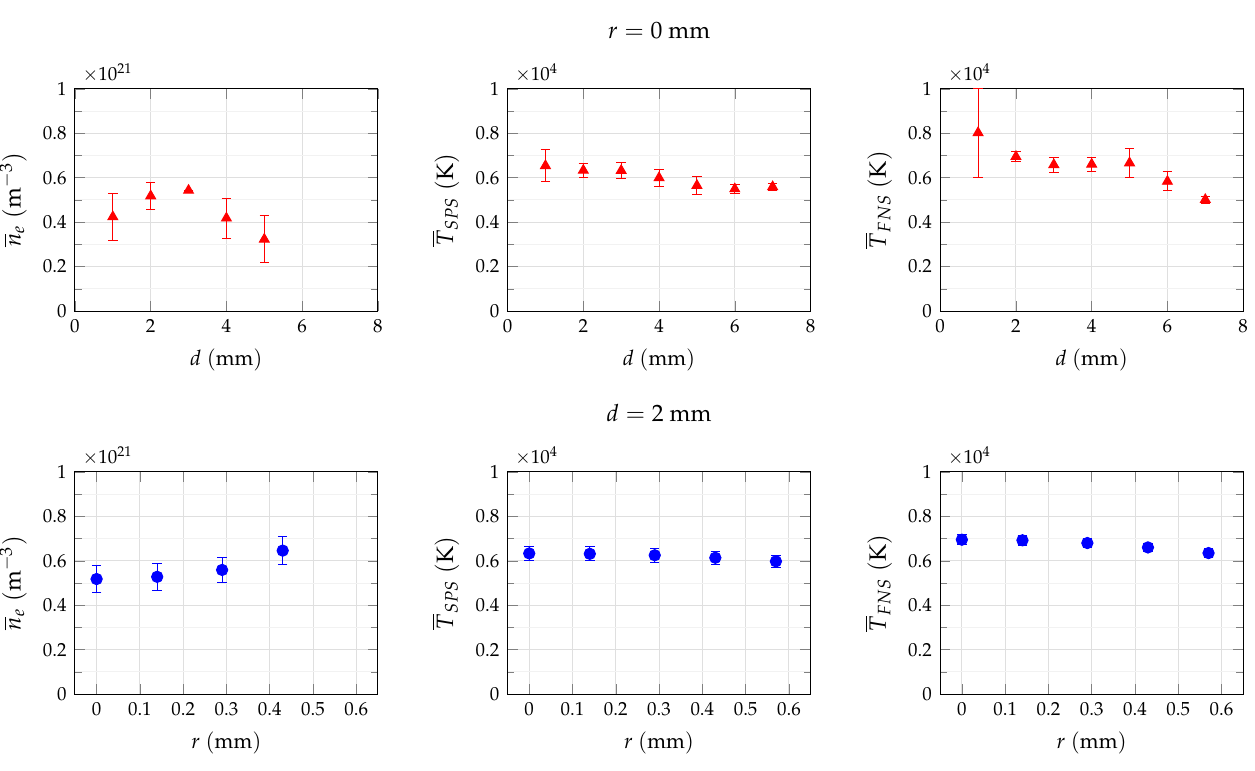
Figure 6. Average electron density ( n e ) and heavy particle temperatures ( T SPS , T FNS ) estimated on nozzle axis (first row of plots denoted with r = 0 mm) for different distances d downstream from nozzle outlet and for different lateral positions r at a distance d = 2 mm (second row of plots). In both cases the experimental setup was triggered at peak current.